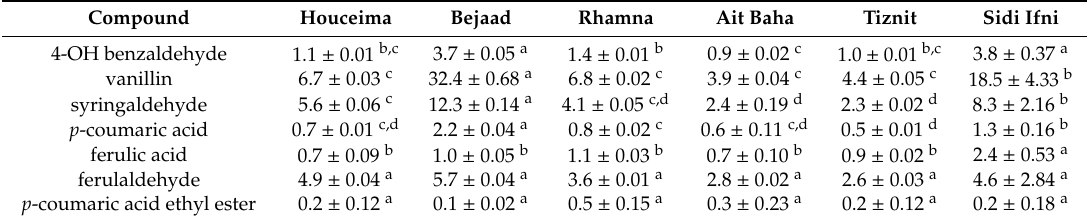
Table 1. Phenolic compounds composition of cactus seed oil from di ff erent region of Morocco expressed in mg / kg and shown as mean ± SD ( n = 3). Statistical di ff erence was determined by one-way ANOVA followed by Tukey post-hoc test. Di ff erent letters in the same line comparing the regions represent statistically significant results at 95% confidence